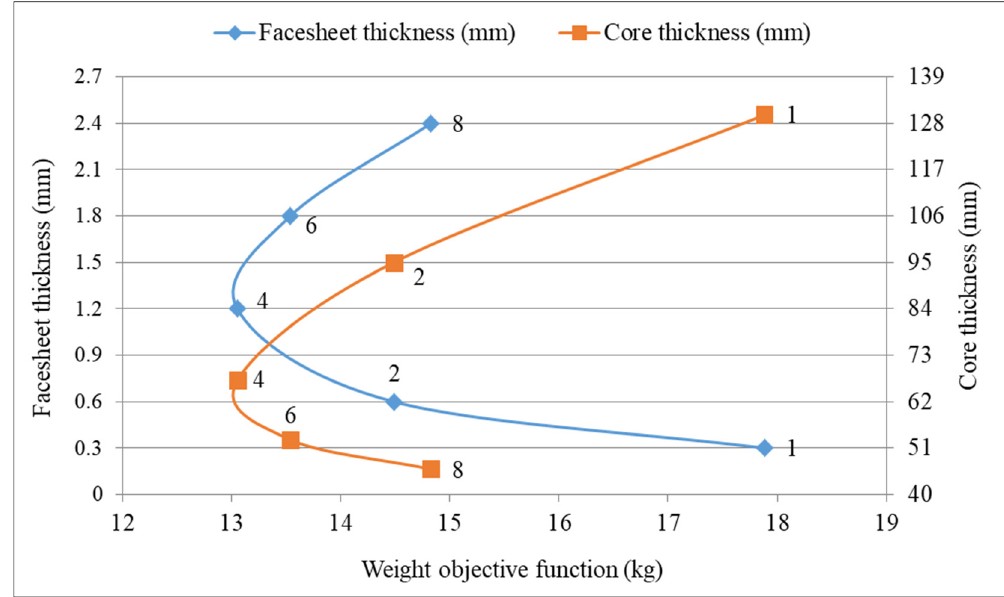
Figure 6. The relationship of the optimal thickness of face sheets and optimal thickness of the core in the case of the minimum weight.